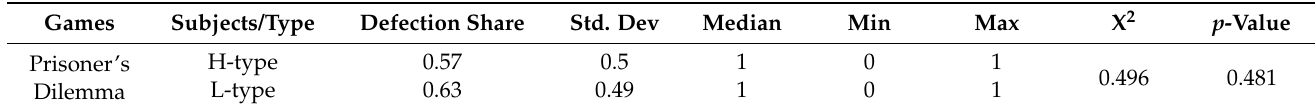
Table 4. Summary and results (Prisoner’s Dilemma by sophistication levels—C1).